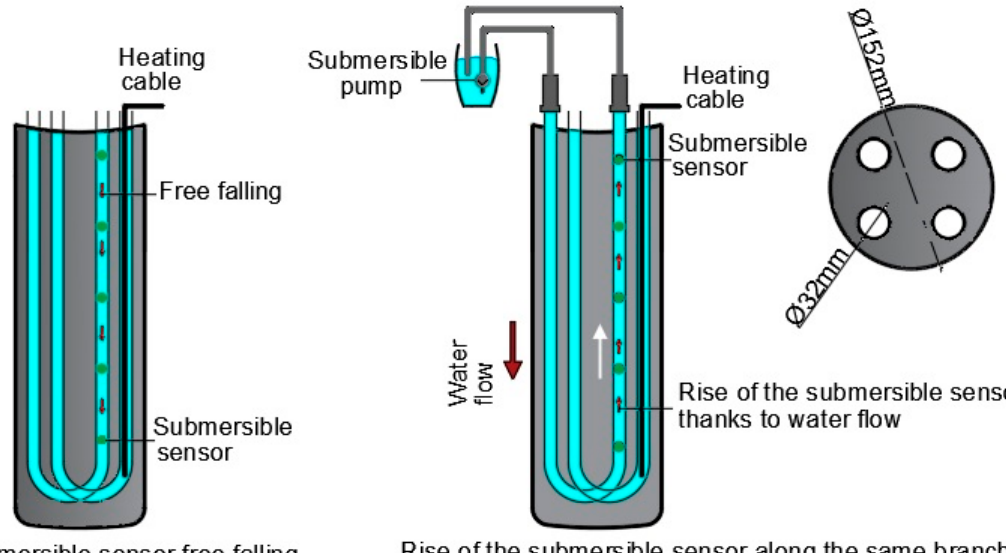
Figure 3. Schematics of the test system, including the heating cable and the submersible sensor moving along one leg of the U-pipe.